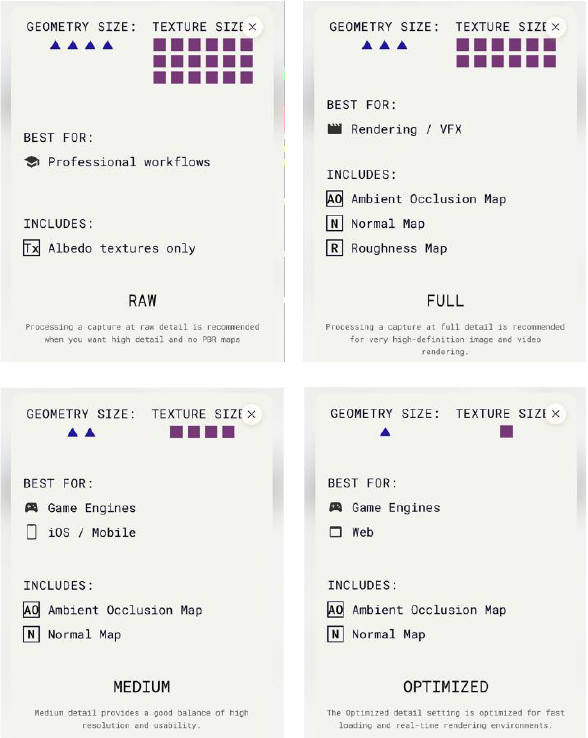
Figure 5. Some views of settings in the Polycam app